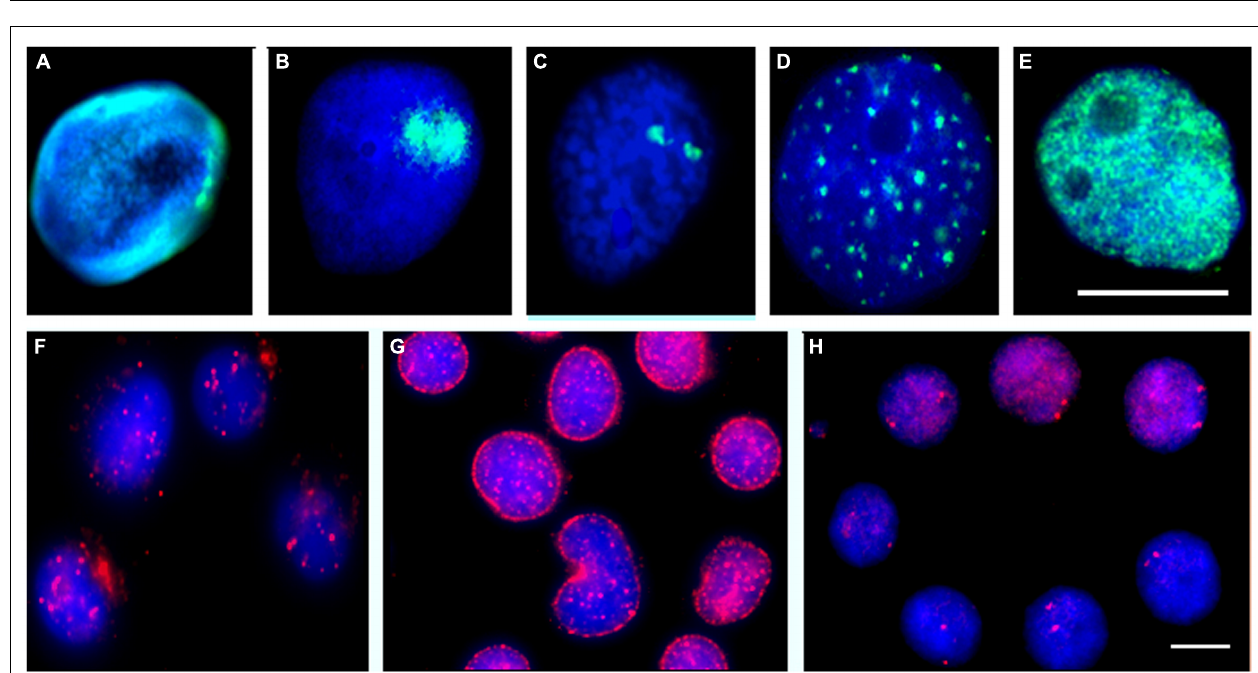
miracidia. Note that expression of the transcripts occurs only in the susceptible but not in the resistant snail (Ittiprasert etal., 2010; Ittiprasert and Knight, 2012).